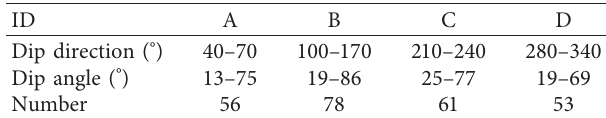
Figure 4: Statistical analysis results: (a) contour plot of the joint plane; (b) rose diagram of dip direction. Table 1: Range of dominant